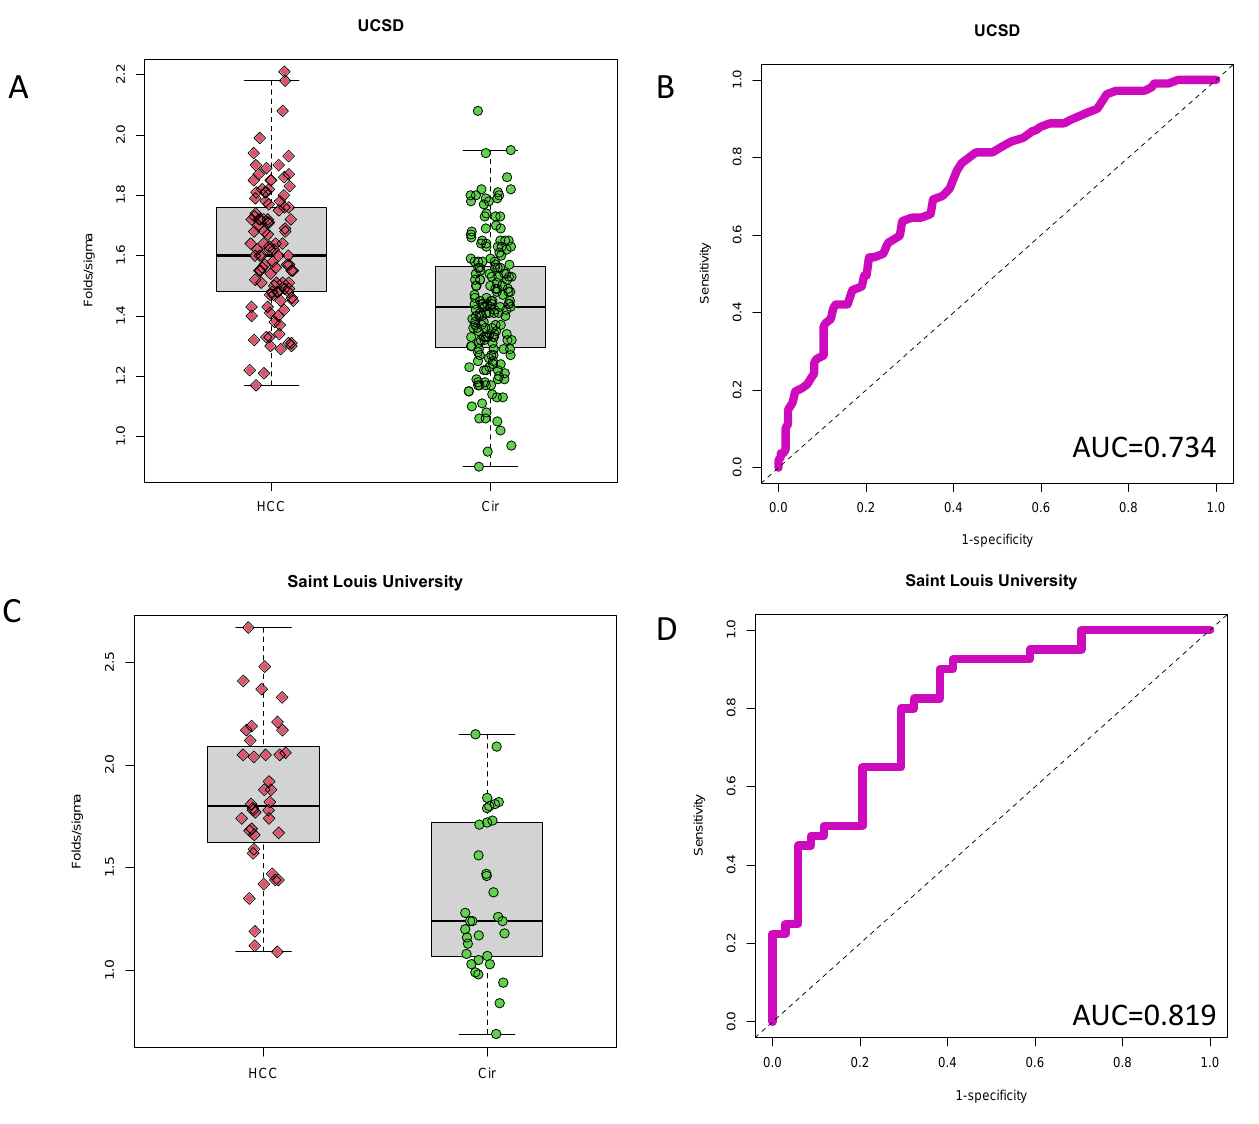
Figure 2. Conformation of PEG-IgG in two other cross-sectional cohorts. ( A ) Box and whiskers plot of PEG-IgG in 107 HCC or 184 cirrhosis samples. ( B ) AUROC of PEG-IgG from cohort shown in panel ( A ), which has a value of 0.734. ( C ) Box and whiskers plot of PEG-IgG in 40 early-stage HCC or 34 cirrhosis samples. ( D ) AUROC of PEG-IgG from cohort shown in panel ( A ), which has a value of 0.819.